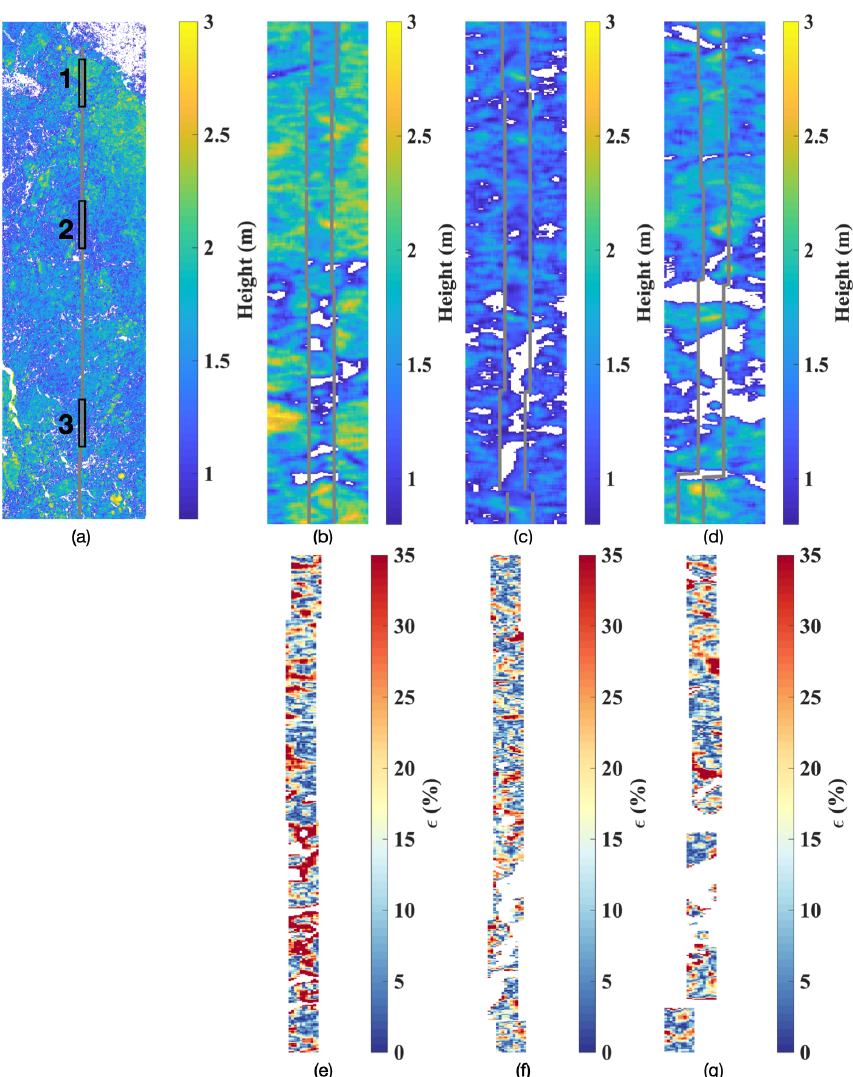
Figure 13. Sea ice topographic retrieval with the simplified model ( h mod_S ). The transect from the DMS DEM is plotted between grey lines. Note that the heights below 0.8m are set to be transparent. (a) The whole studied SAR image. (b–d) Close-up of areas 1–3. (e–g) Relative retrieval bias (cid:15) = | h mod_S − h DMS | /h DMS of area